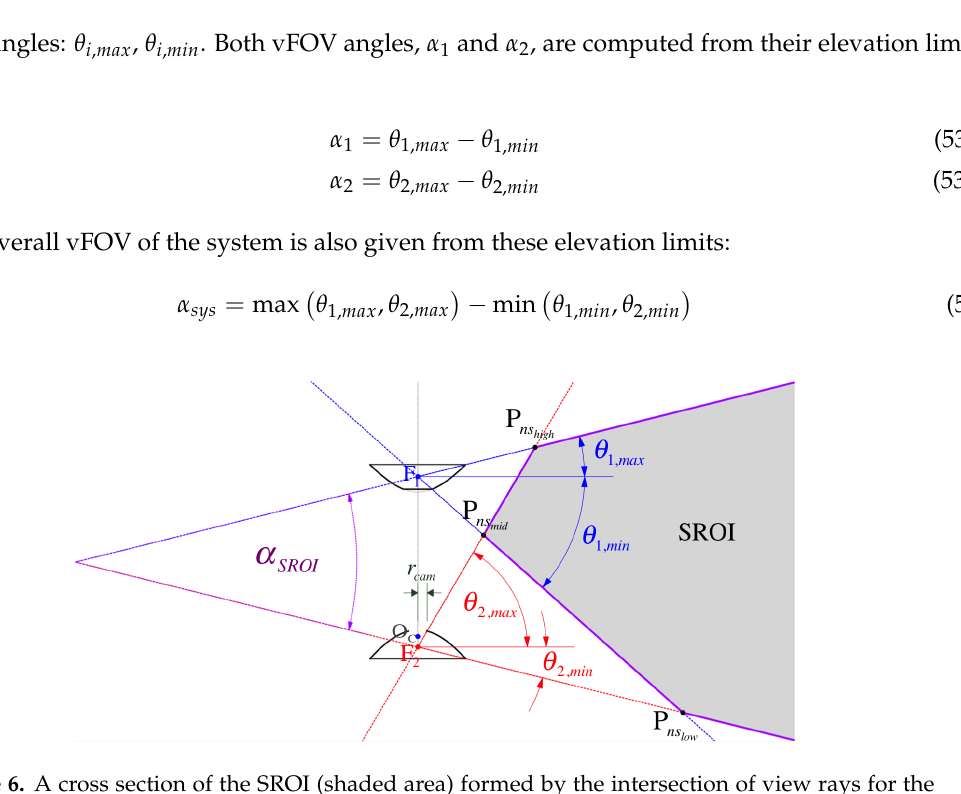
, P ns and P ns since high mid low